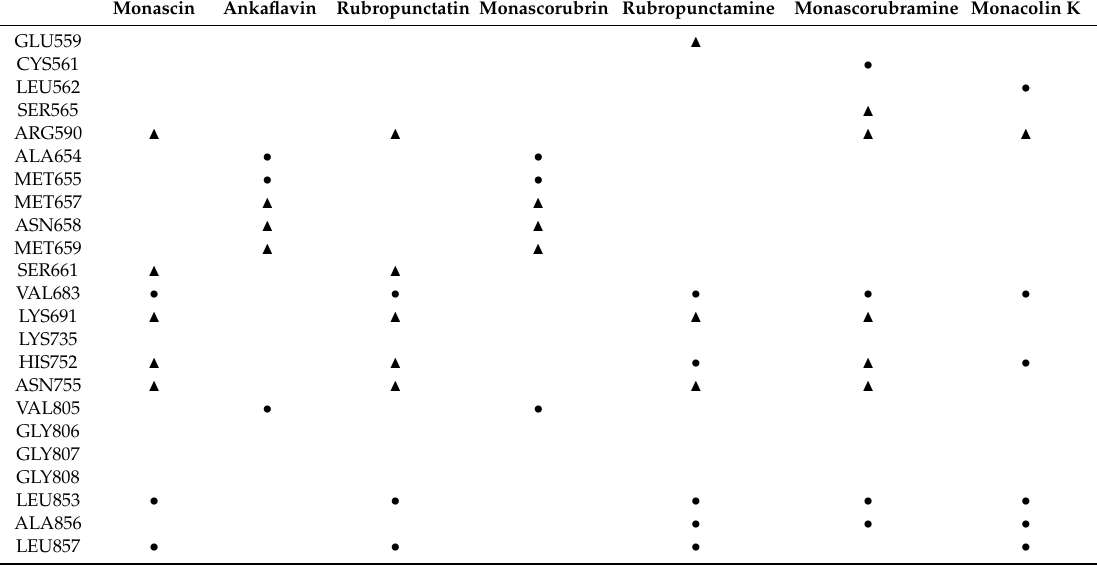
Table 3. HMGR (PDB: 1HW9) interact with docked MPs. ( • : hydrophobic interactions; (cid:78) : hydrogen